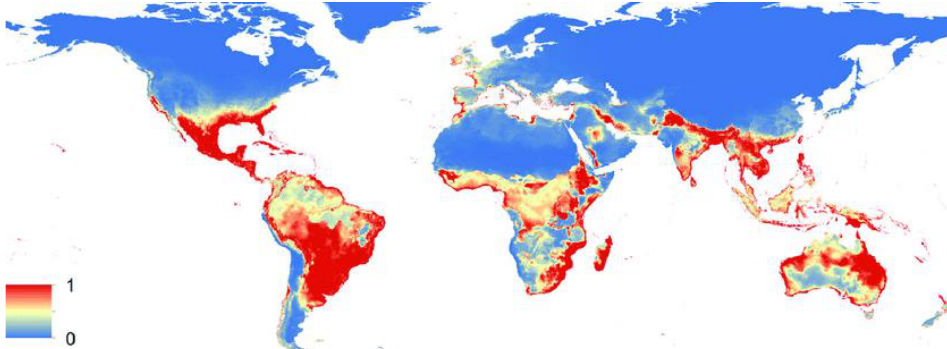
Figure 2. Estimated potential global distribution of Culex quinquefasciatus . The colors represent the suitability level from 0 (blue) to 1 (red). C. quinquefasciatus is a known competent biological vector of WNV. In addition, recent evidence suggested its potential as vector for ZIKV [13,14]. Adapted with permission from Ref. [13]. Copyright 2018 Alaniz, A.J.; Carvajal, M.A.; Bacigalupo, A.; Cattan, P.E.